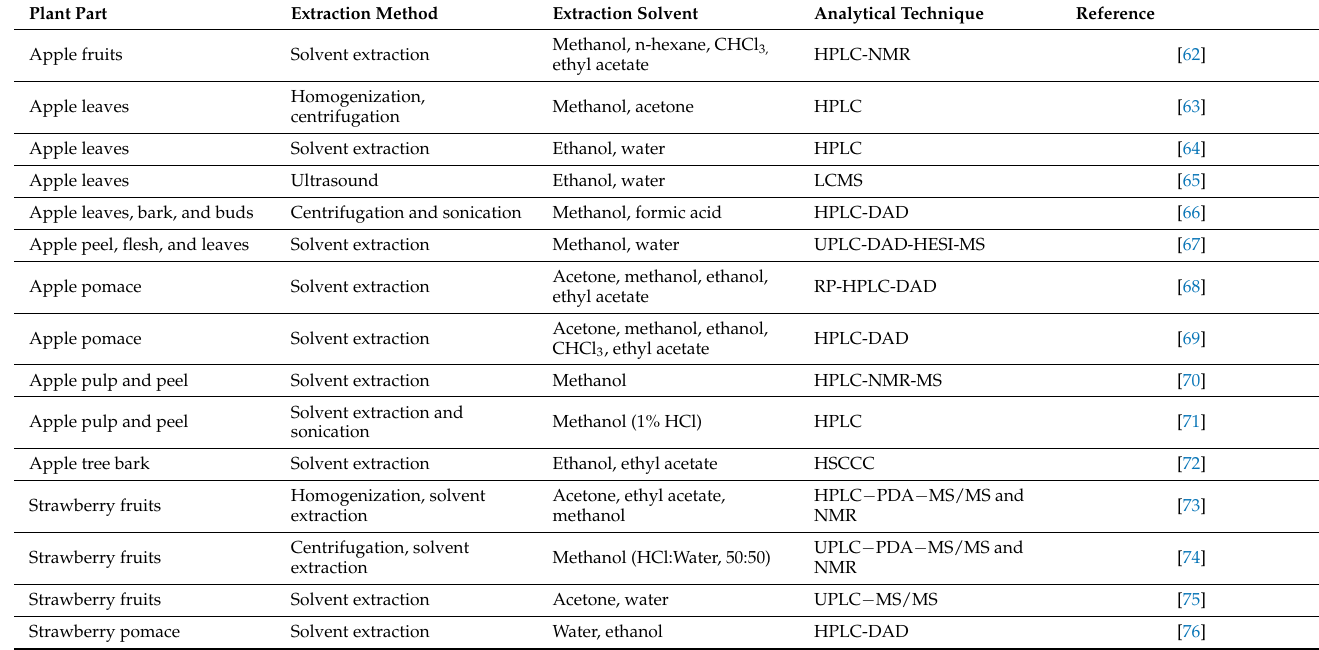
Table 1. Extraction and characterization of phloretin.